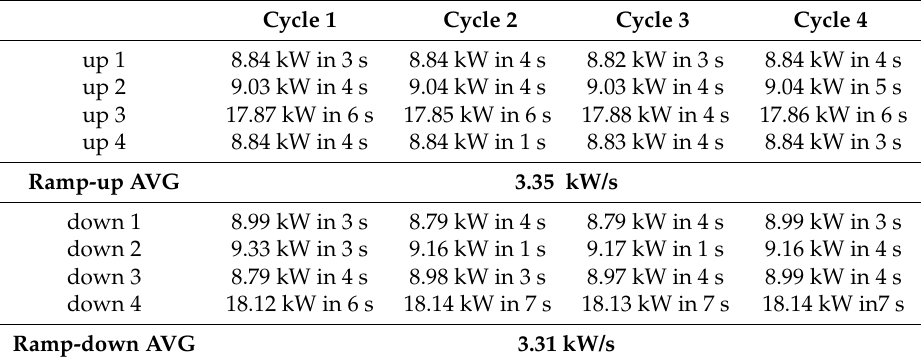
Table 1. Measured ramping rates